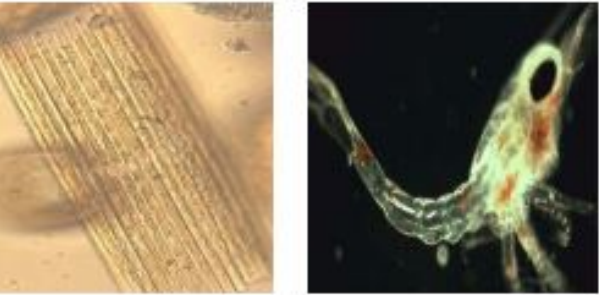
Figure 7. ( Left ): Bacillaria paxillifera, phytoplankton. ( Right ): Anomura Galathea zoea,